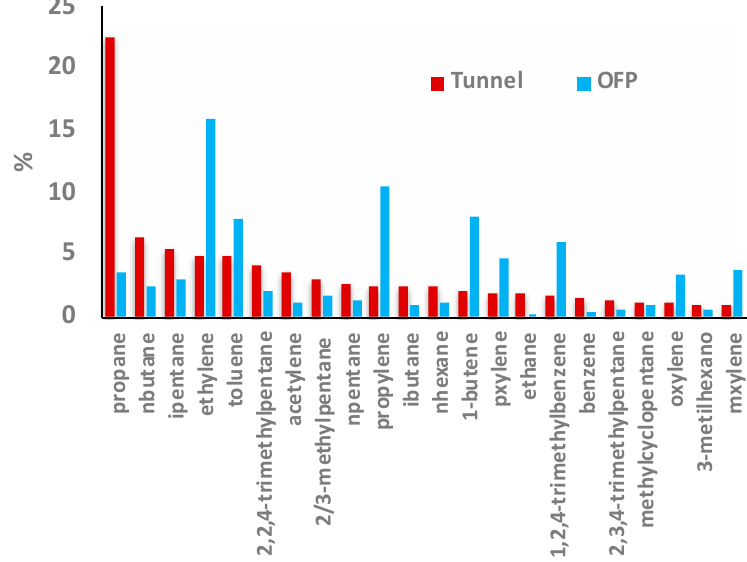
Figure 6. Contributions of the most abundant compounds to ozone formation potential (OFP) measured in tunnels.